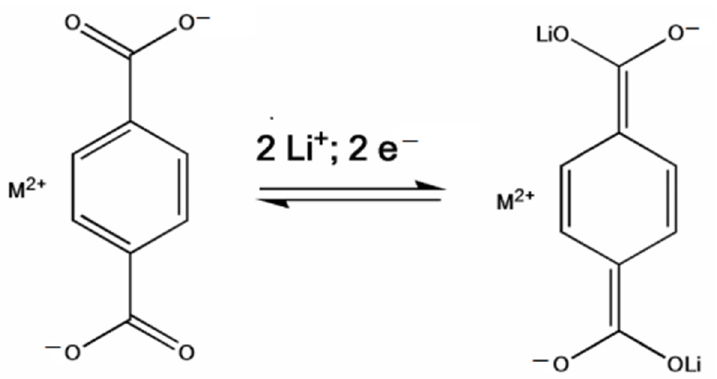
Figure 5. Schematic depicting the lithium storage/release mechanism of carbonyl-based terephthalates at the molecular structure level. Reprinted from Ref. [73], Copyright 2016, with permission from Elsevier.